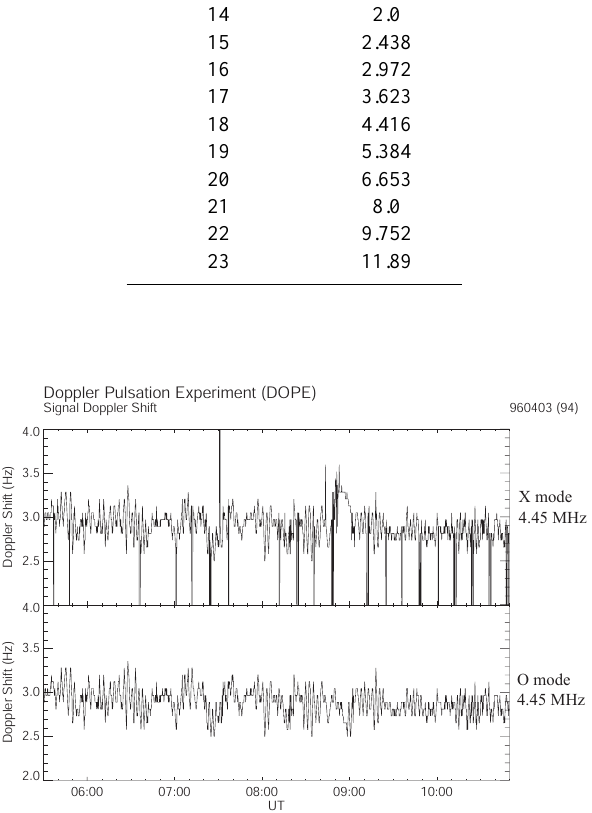
Figure 2. Fig. 2. An example of a Doppler trace using the original 2 beam DOPE system. A ULF wave signature is seen in both channels, although predominantly in channel 2 (O mode), between 05:30 to 10:30 UT. The DOPE sounding frequencies are shown to the right of each trace. Both traces show unfiltered data and as such there are data spikes, probably due to HF noise, in panel ( a ) .